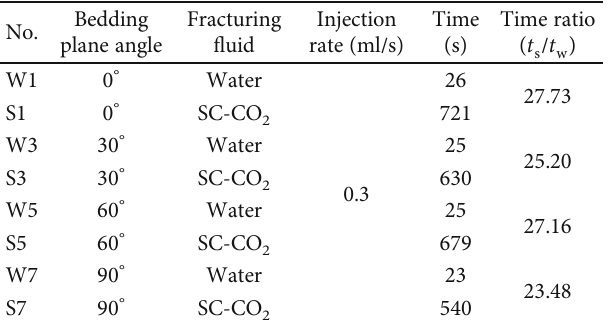
Figure 4: Typical pump pressure curves of shale fractured using water and SC-CO . 2 Table 2: Time comparison of pump pressure to peak using water and SC-CO 2